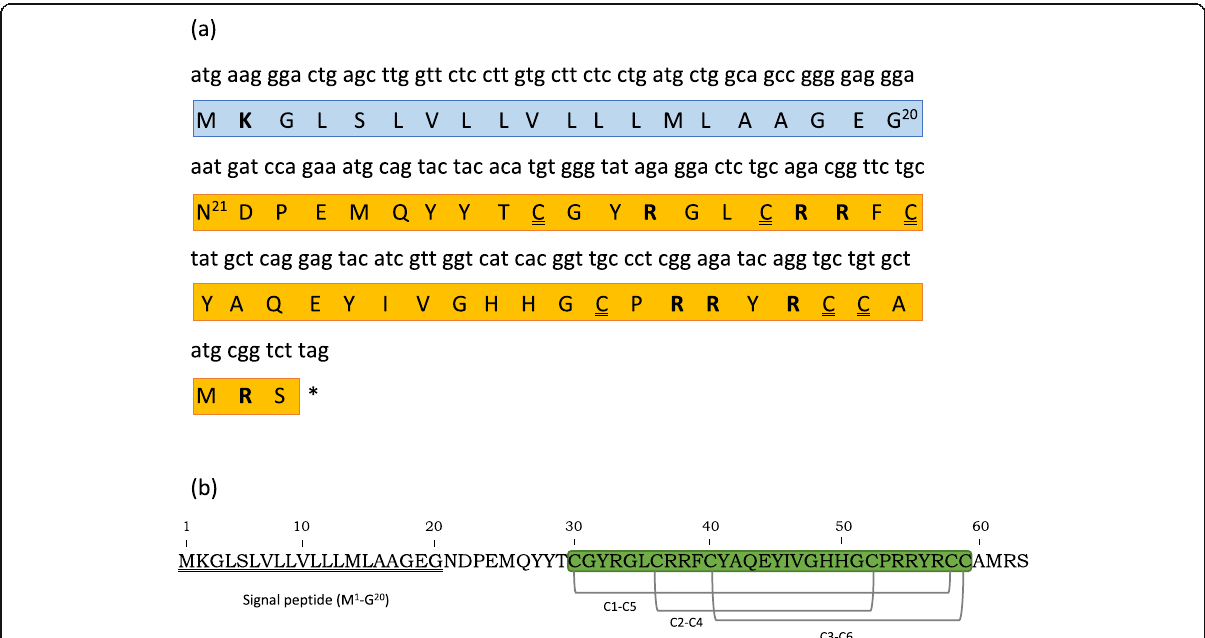
Fig. 2 a cDNA (192 bp) and deduced amino acid (63 aa) sequences of β -defensin from Odonus niger . The blue boxed amino acid sequences (20 aa) denote the signal peptide region with cleavage site predicted in between the Gly 20 -N 21 residues with SignalP-5.0. The remaining 43 aa residue of mature peptide sequence is in yellow shade. All positively charged residues are shown in bold, and the cysteine residues are double- underlined. ‘ * ’ denotes termination. b An illustration of the SMART and Pfam identified β -defensin domain is shown in green shade (C 30 – C 59 ) within which three predicted disulfide bonds of the pattern C1 – C5, C2 – C4, and C3 – C6 are